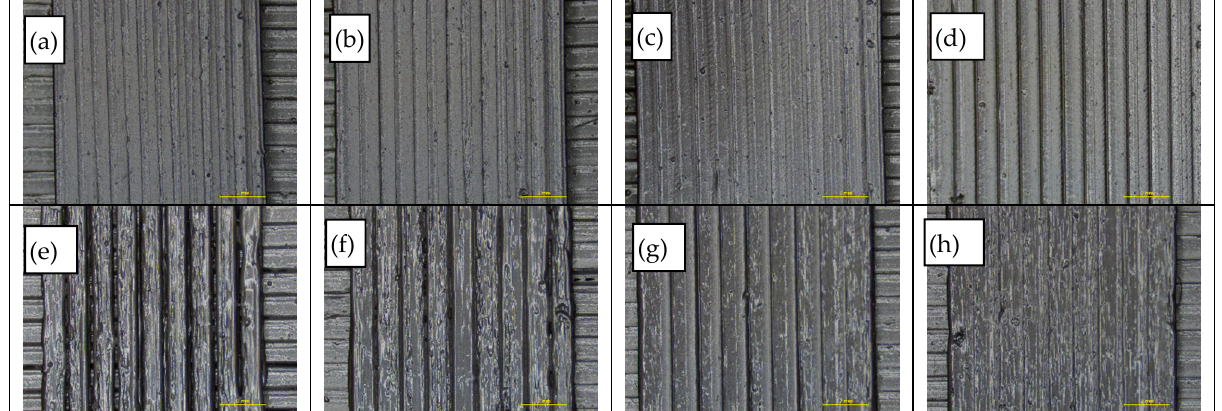
Figure 14. Optical inspection via stereomicroscope (7×) of specimens obtained from varying strand widths (SW) and the extrusion multiplier (EM): ( a – d ) SW = 0.80, 0.90, 1.00, 1.10 mm from left to right; (e–h) EM = 0.8, 1.0, 1.2, 1.4 from left to right.